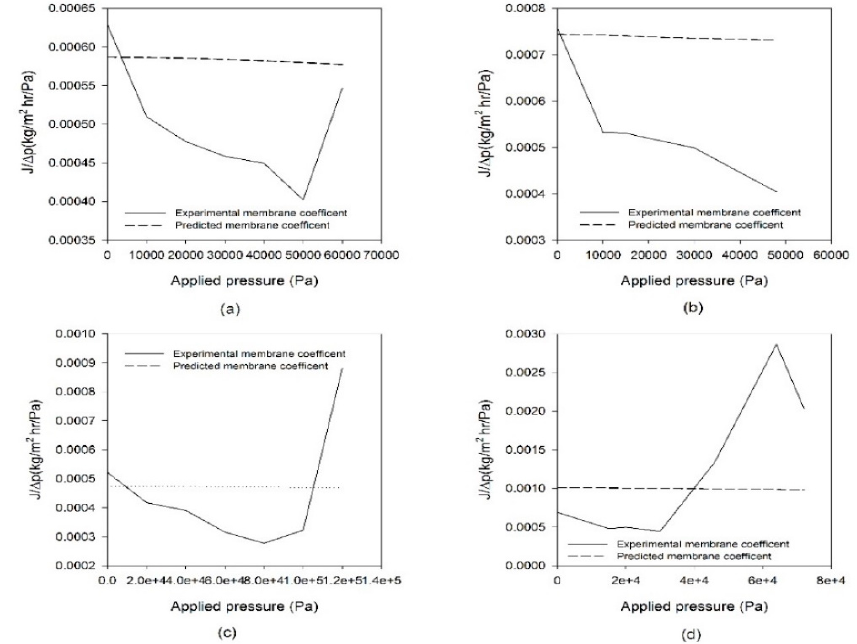
Figure 10. Comparison of mass transfer coefficients from model prediction and experimental measurement. ( a ) FGLP membrane, ( b ) FHLP membrane, ( c ) GVHP membrane and ( d ) HVHP membrane.